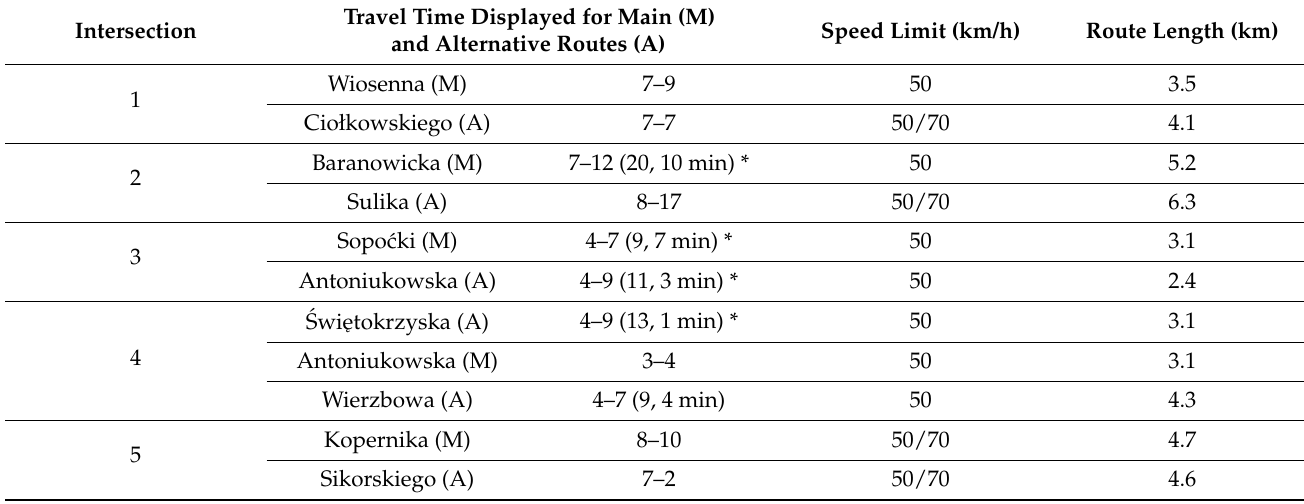
Table 1. Description of investigated routes managed by VMSs.